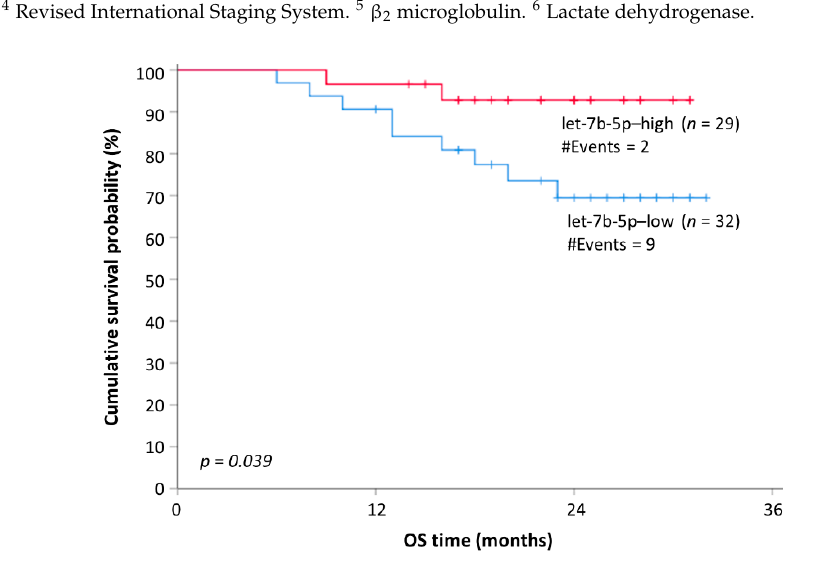
Figure 5. Kaplan–Meier survival curves for overall survival (OS) of MM patients. Reduced plasma levels of let-7b-5p were shown as potentially unfavorable molecular markers of prognosis in Table 4. Cox regression analysis regarding the prognostic potential of circulating let ‐ 7b ‐ 5p status for the OS of MM patients. Variable (Tested vs. Control)